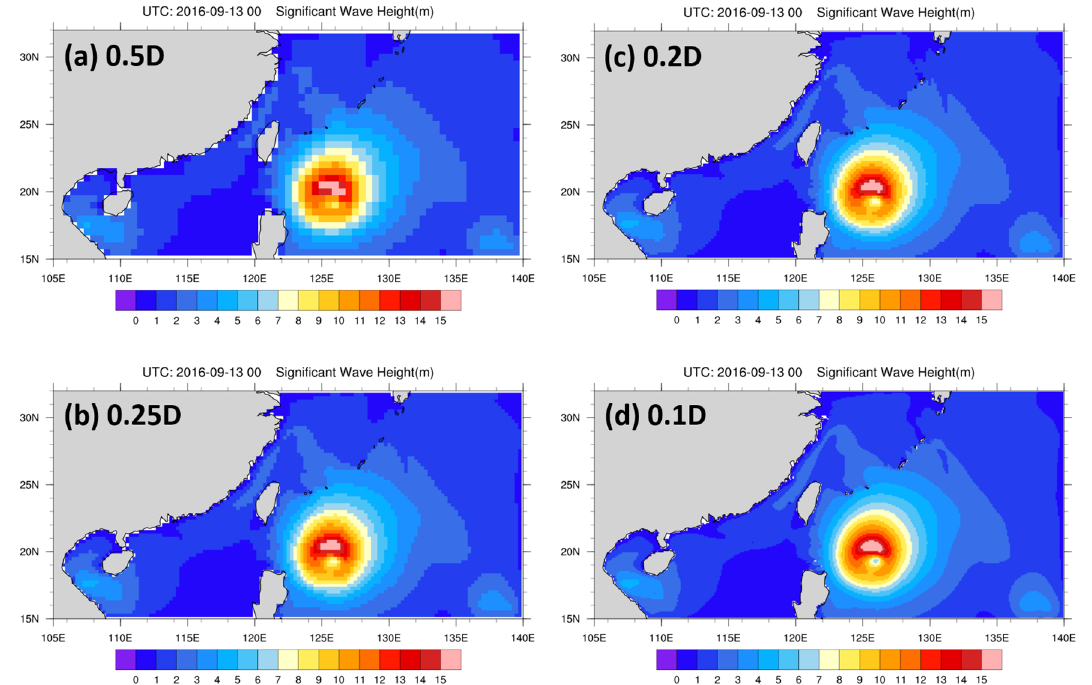
Figure 7. Spatial distribution of Typhoon Meranti significant wave height driven by CFSv2 using the WW3 model with ( a ) 0.5 deg, ( b ) 0.25 deg, ( c ) 0.2 deg, and ( d ) 0.1 deg grid resolutions.